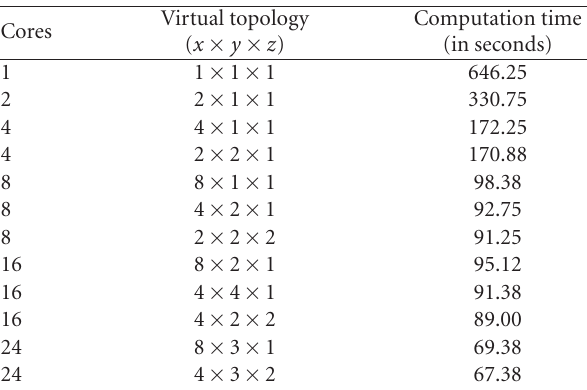
Table 1: Comparisons of computation